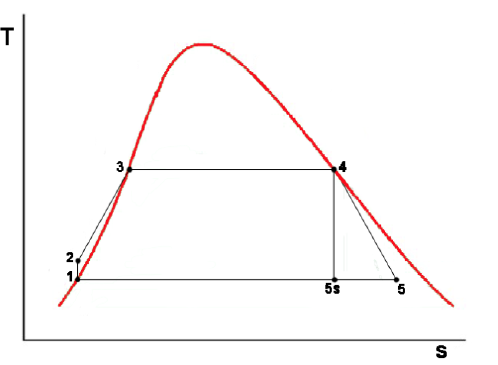
Figure 2. Temperature-Entropy diagram of power cycle at reference state.